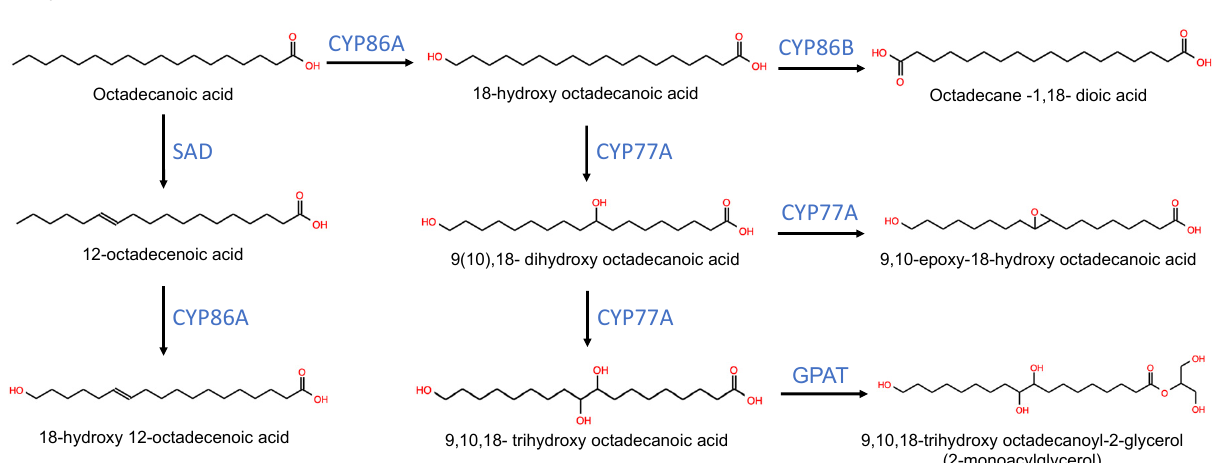
Figure 1. Biosynthesis pathway and chemical structure of common cutin monomers found in the fleshy fruit cuticle. Only the gene subfamily’s main name is included for reactions involving multiple paralogs. 9-hydroxy fatty acid structures are used to represent both 9 and 10 hydroxy fatty acid monomers. The main C 16 and C 18 monomers are used to exemplify the structure of 2-monoacylglycerol monomers. Abbreviations: Cytochrome P450 subfamily 86A, 86B and 77A (CYP86A, CYP86B and CYP77A, respectively); StearoyI-ACP desaturase (SAD); Glycerol-3-phosphate acyltransferase (GPAT). The figure was built based on the literature [5,8,16,82–89]. Chemical structures were drawn with the JSME Molecular Editor [96].